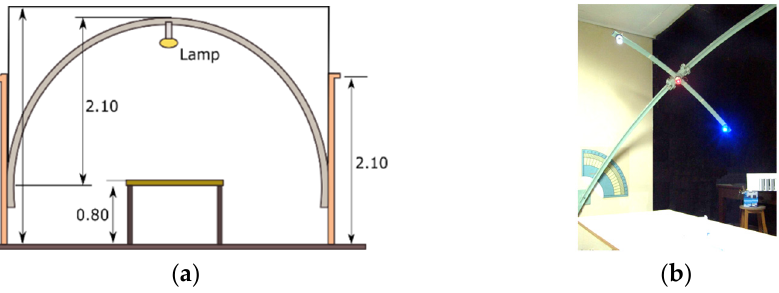
Figure 4. Heliodon designed by Maristany et al. in 2007: ( a ) front view and ( b ) isometric view.